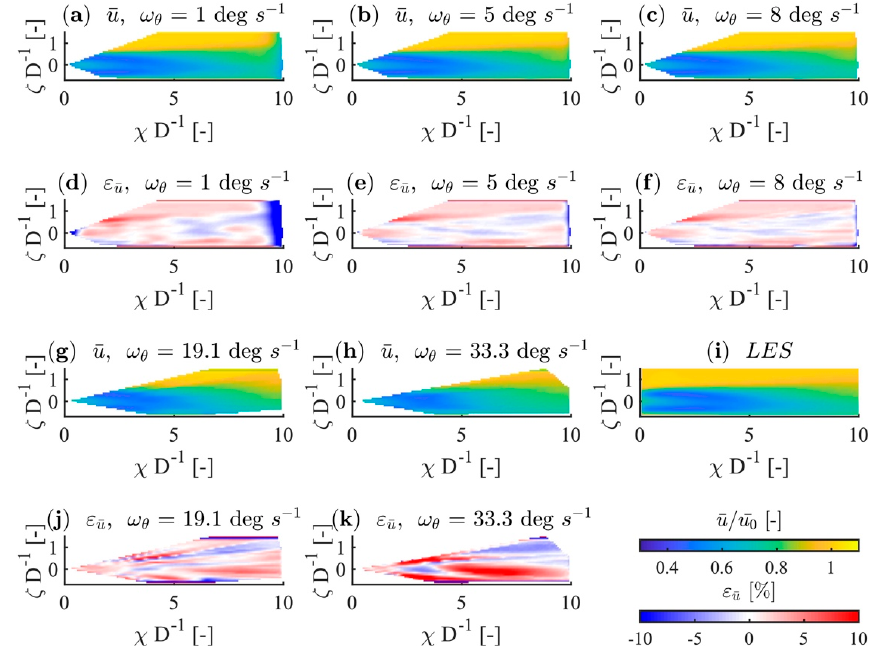
Figure A3. Visualisation of the normalised 10-min averaged wind-speed component, u , of the propagated RHI data and ( d – f ) and ( j – k ) the corresponding flow deviations, ε u , from ( i ) the normalised 10-min averaged wind-speed component, u , of LES